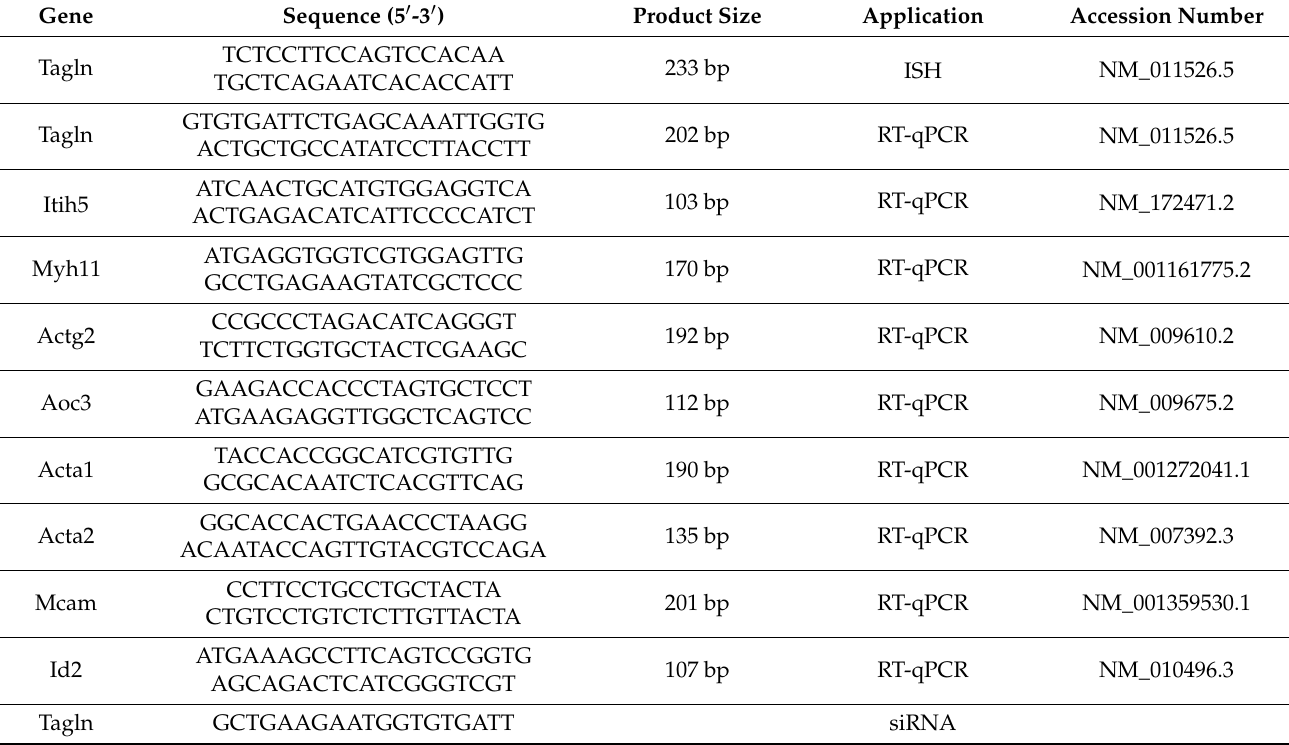
Table 1. Primer sequences were used in this